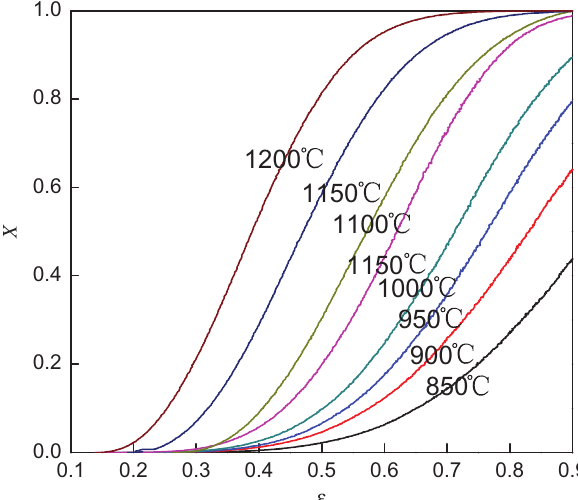
Figure 8: Relationship between X and ε